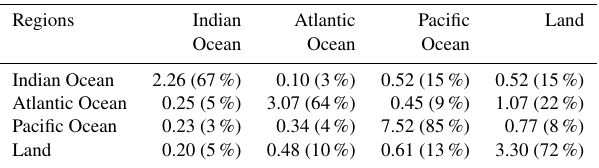
Table 1. Atmospheric freshwater transport within and between the ocean basins and land. The rows represent net evaporative (atmo- spheric water source) sectors and the columns represent the net precipitation (atmospheric water sink) regions. Units are in Sv ( ≡ 10 9 kgs − 1 ). The percentages in the parentheses represent frac- tions of the net evaporation that are transported from the source